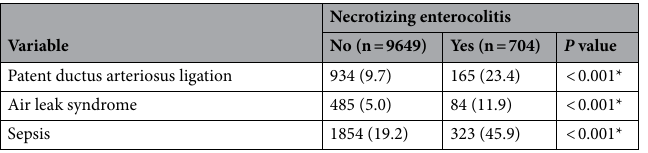
Table 2. Univariate Analysis. Values are presented as number (%) or mean ± standard deviation. Abbreviations: DM, Diabetes mellitus; PROM, Pre-labor rupture of membrane; PM 10 , particulate matter concentration. * P < 0.05 Chi-Square Test for the Equality of Proportions “Yes” or T Test for the Equality of Means.